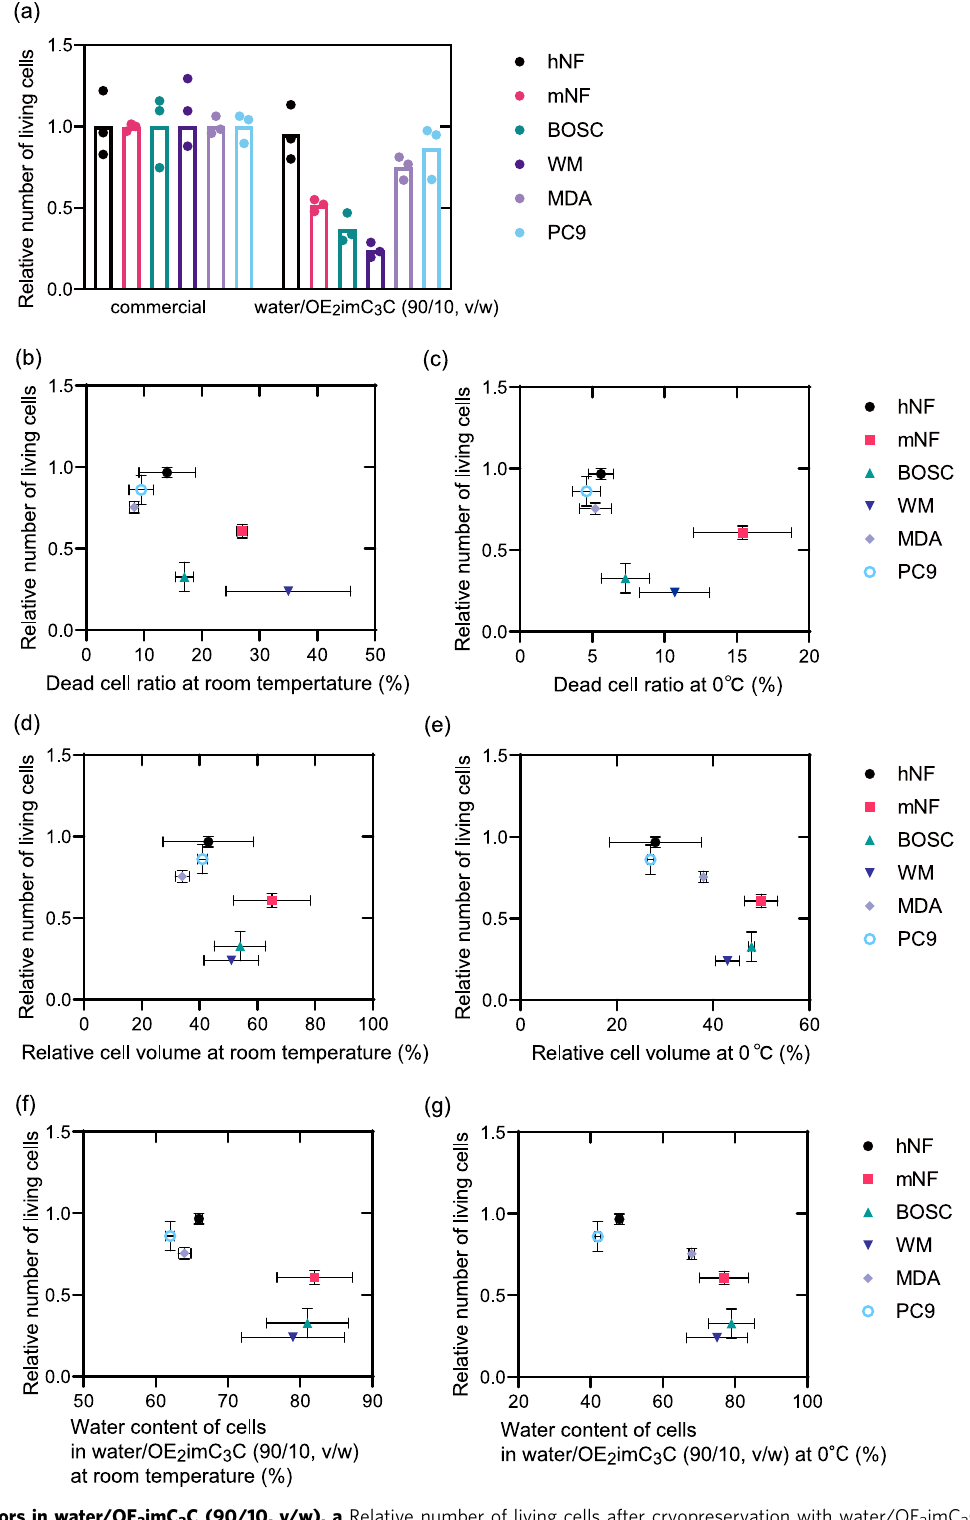
Fig. 3 Cell behaviors in water/OE 2 imC 3 C (90/10, v/w). a Relative number of living cells after cryopreservation with water/OE 2 imC 3 C (90/10, v/w) ( n = 3, experimentally triplicate). b , c Relation between relative number of living hNF, mNF, BOSC, WM, MDA, and PC9 cells and dead cell ratio at b room temperature and c 0 °C after 60 min of immersion in the indicated solution ( n = 3, biologically triplicate). d , e Relation between a relative number of living hNF, mNF, BOSC, WM, MDA, and PC9 cells and relative cell volumes at d room temperature and e 0 °C after 5 min of immersion in the indicated solutions (cell volumes at the same temperature in PBS were standardized as 100%). f , g Relation between that the water contents of cells in water/OE 2 imC 3 C (90/ 10, v/w) at f room temperature and g 0 °C and the relative numbers of living hNF, mNF, BOSC, WM, MDA, and PC9 cells. ( n = 3, biologically triplicate). b – e These cells were immersed as fl oating cells in the solutions after trypsinization. The bars show standard error.